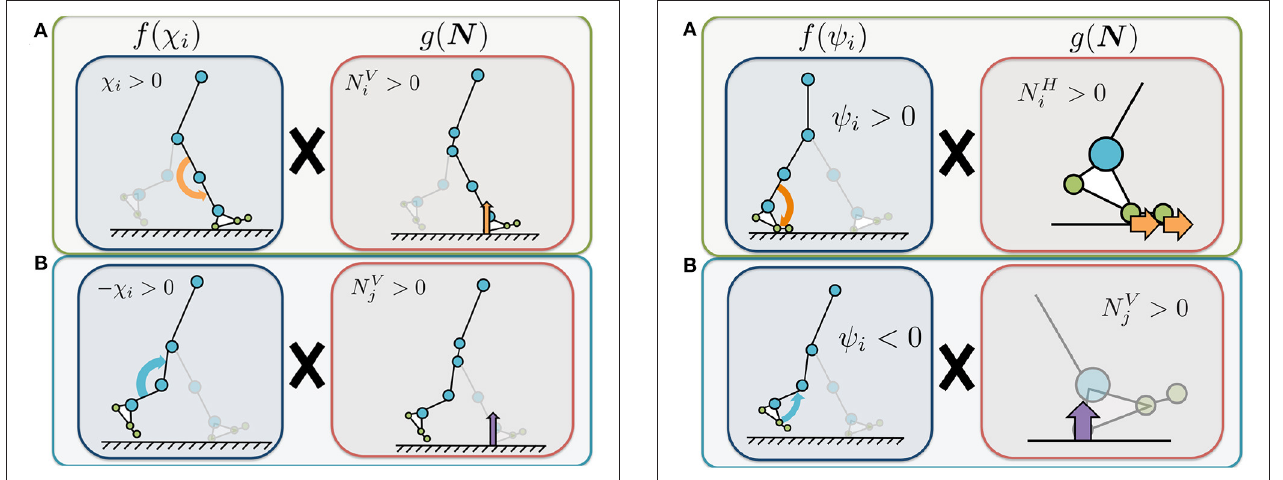
FIGURE 4 | Illustrated definition of the Tegotae function for the knee controller. The control variable χ i represents the control command that increases or decreases the knee joint stiffness (Equation 9). We use χ i to adjust the P-gain K knee , i in the knee controllers for the implementation of stiffness control mechanism, in Equation (10). N V i and N V j represent the sums of the vertical force sensor values corresponding to the heel, metatarsal, and toe joints of the corresponding ( i ) and opposite ( j ) legs, respectively. (A) Tegotae function for corresponding-leg sensory information. The value of N V i χ i is positive when the foot sensors on the corresponding leg detect a large vertical GRF ( N V i > 0) and the control command for the knee is to increase the stiffness (i.e., χ i > 0). (B) Tegotae function for opposite-leg sensory information. The value of N V j ( − χ i ) is positive when the foot sensors on the opposite leg detect a large vertical GRF ( N V j > 0) and the control command for the knee is to decrease the stiffness (i.e., χ i < 0).